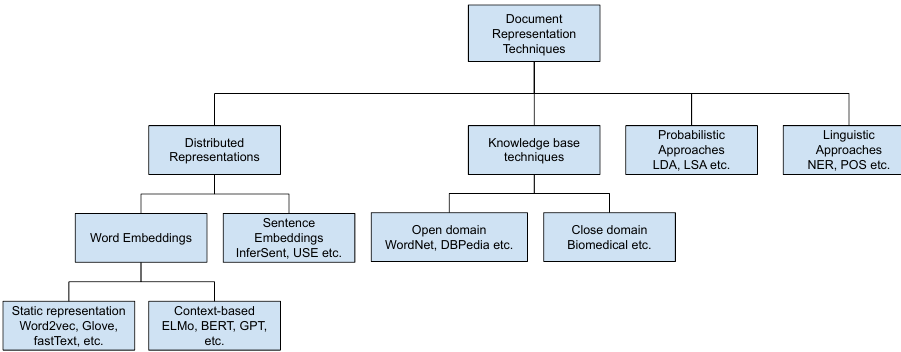
Figure 1. A taxonomy of document representation enhancement